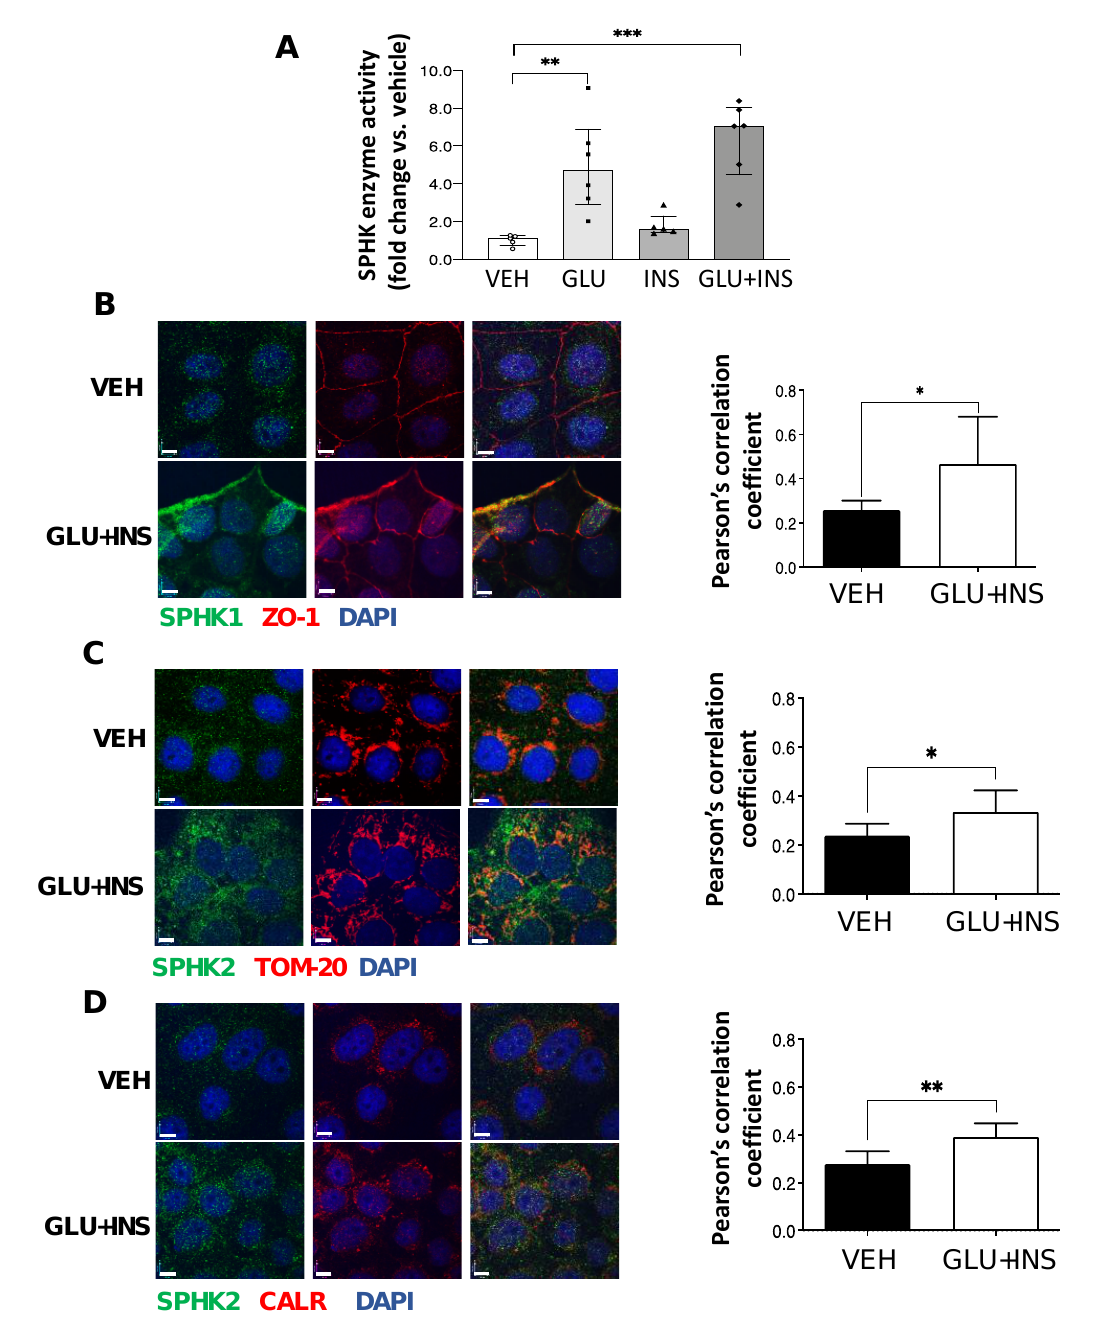
Figure 3. Subcellular distribution of sphingosine kinase (SPHK) isoenzymes in placental JEG3 cells in response to diabetic conditions. ( A ) SPHK activity in choriocarcinoma JEG-3 cells exposed to VEH (Eagle’s Minimal Essential Media), GLU (25 mM), INS (0.85 µ M), or GLU+INS. Data are median ± IQR. * p < 0.05, ** p < 0.01, *** p < 0.001, ( B – D ) Immunofluorescence (IF) analysis of SPHK1 and 2 in choriocarcinoma JEG-3 cells exposed to VEH (Eagle’s Minimal Essential Media) or GLU (25 mM) + INS (0.85 µ M). JEG3 were stained for ( B ) SPHK1 (green), nuclei (DAPI blue) and plasma membrane marker ZO-1 (red); ( C ) SPHK2 (green), nuclei (DAPI blue) and mitochondrial marker TOM20 (red); and ( D ) SPHK2 (green), nuclei (DAPI blue) and endoplasmic reticulum marker calreticulin (CRT) (red). Colocalization analysis (Pearson’s correlation coefficients) was performed on 7 images of VEH-treated cells and 8 images of GLU+INS-treated cells from 2 separate experiments. Data are mean ± SD. * p < 0.05; ** p < 0.01. Scale bars are equivalent to 7 µ